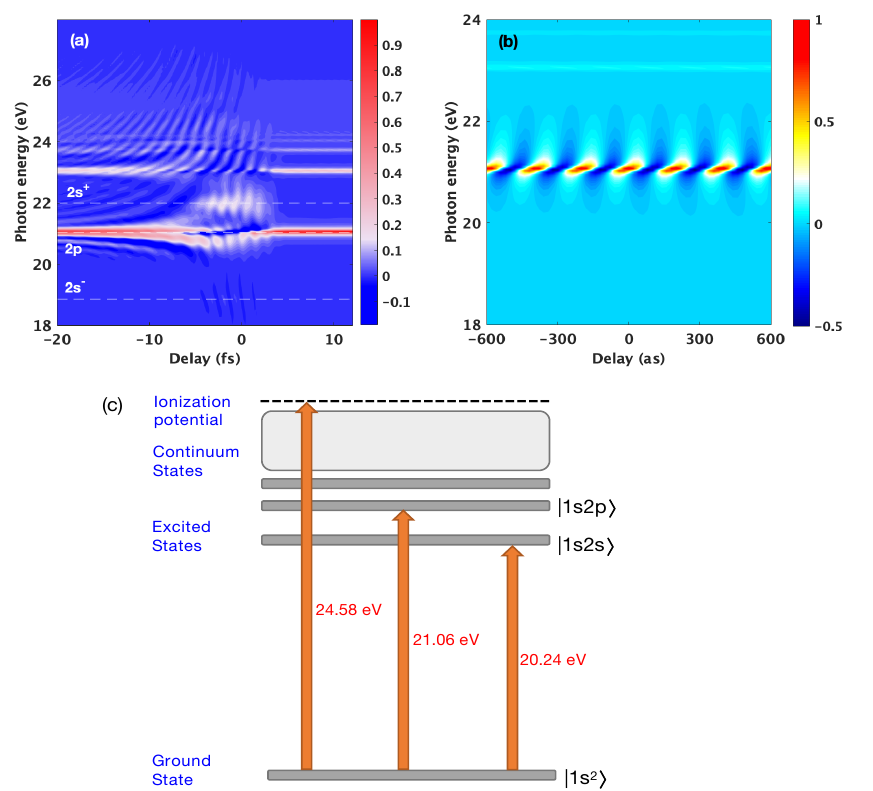
Figure 1. The ATAS (color-coded) of a helium atom obtained using the response function S ( ω , t d ) . ( a ) ATAS for XUV+IR, ( b ) ATAS for XUV+VUV. ( c ) The relevant level scheme of a helium